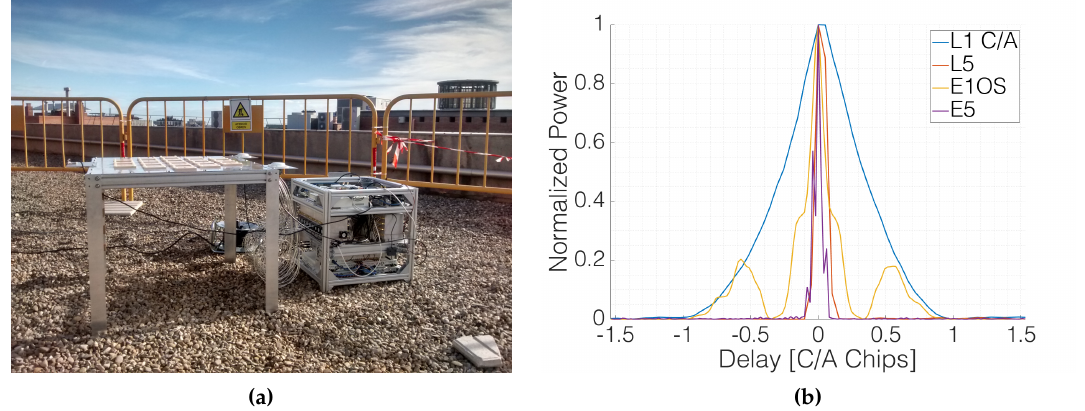
Figure 26. MIR up-looking array and rack during the rooftop experiments ( a ), and retrieved waveforms from GPS and Galileo satellites in both L1/E1 and L5/E5 frequency bands ( b ) during the rooftop experiments [23].